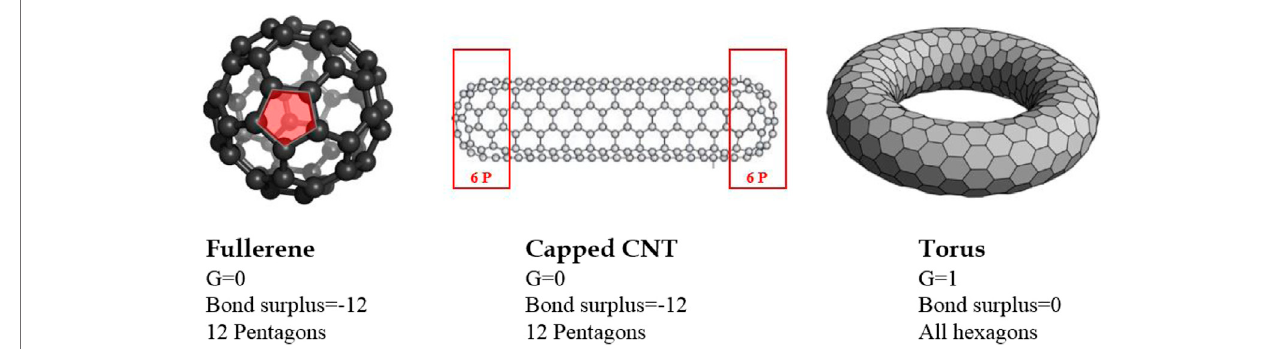
FIGURE 2 | Bond surplus and the associated defects in the polyhedron nanostructures.